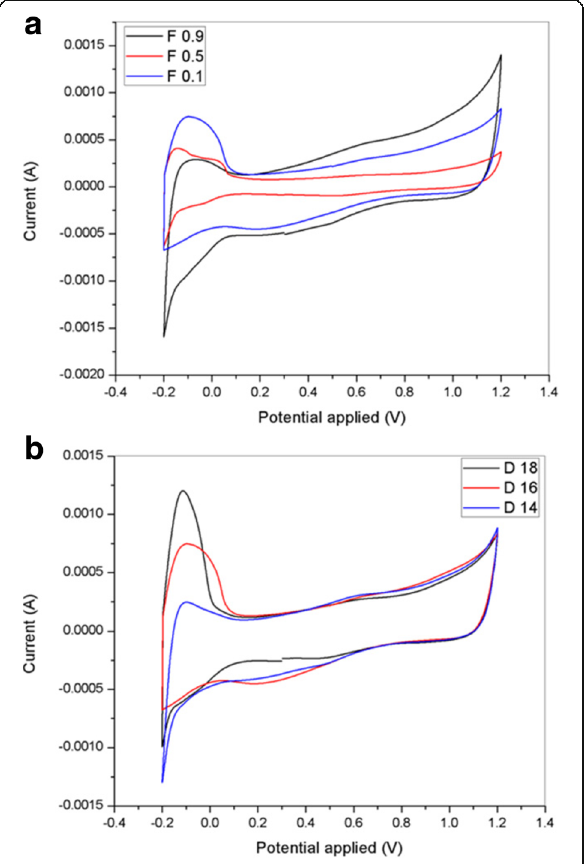
Fig. 12 Cyclic voltammetry profiles of the PtRu/TiO 2 -CNF with a different flow rate, F0.1, F0.5, F0.9, and b different DTC, D14, D16, and D18, in 0.5 M H 2 SO 4 solution at the scan rate of 50 mVs −